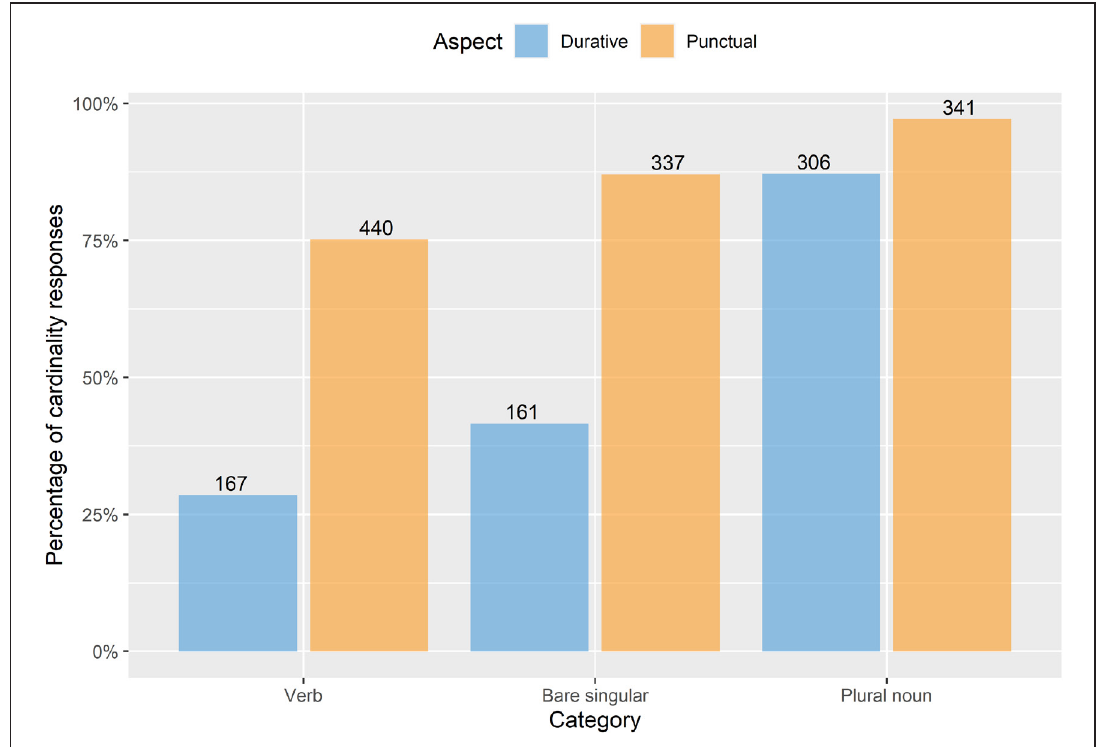
Figure 2: Percentage of cardinality responses considering durative and punctual aspectual fea- tures and the categories of verbs, bare singulars and plural nouns.